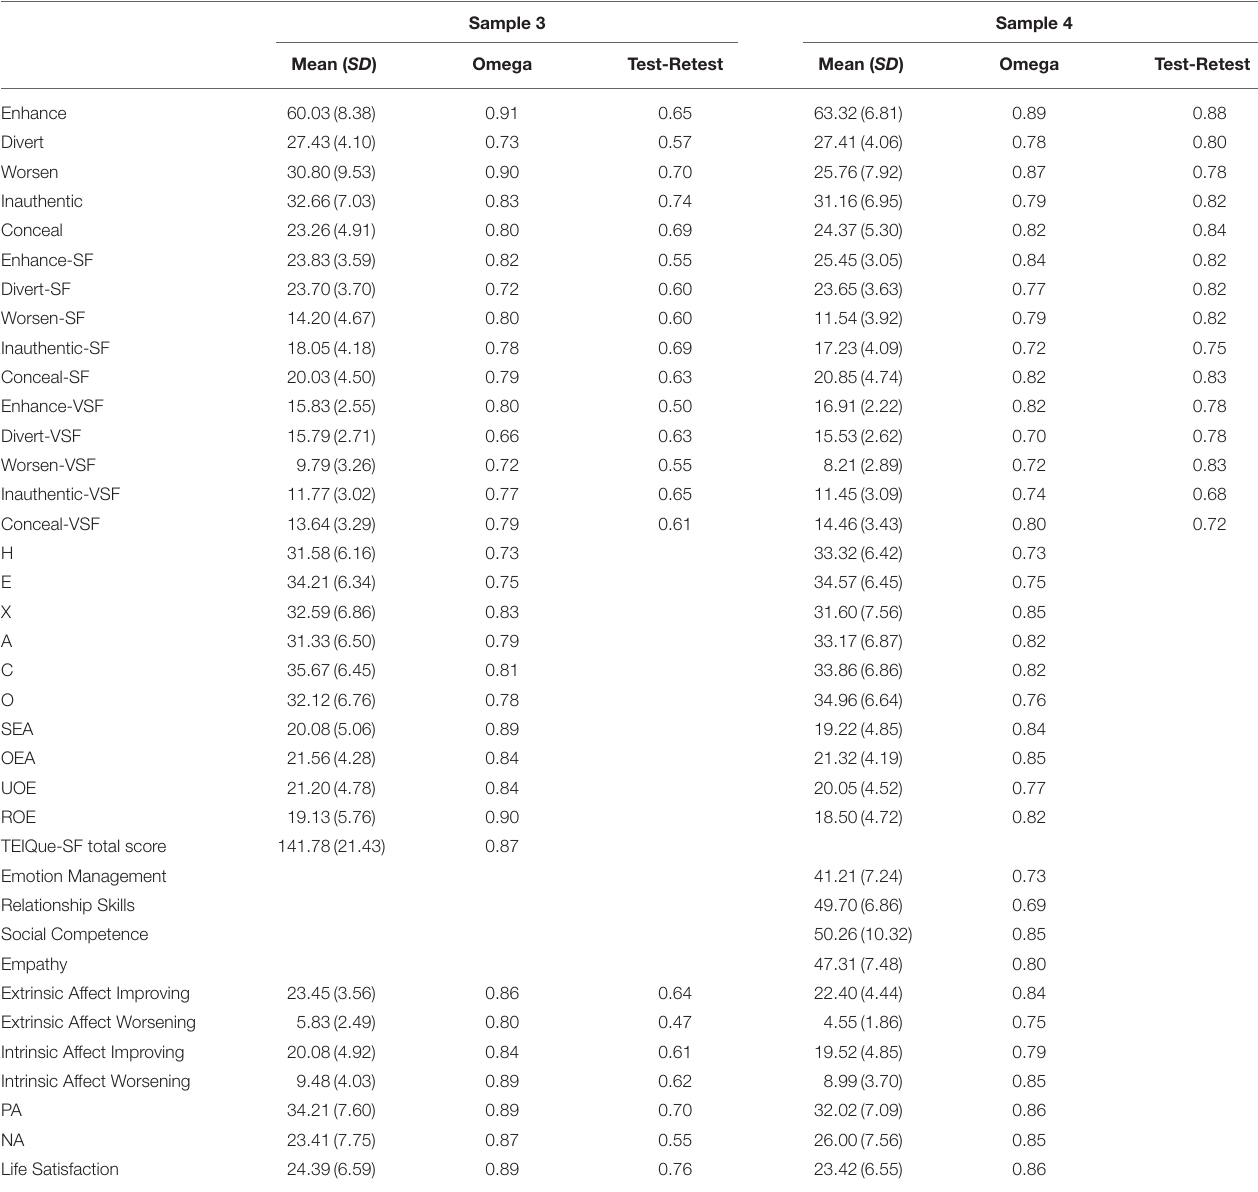
TABLE 11 | Descriptive statistics, internal and test-retest reliabilities for samples 3 and